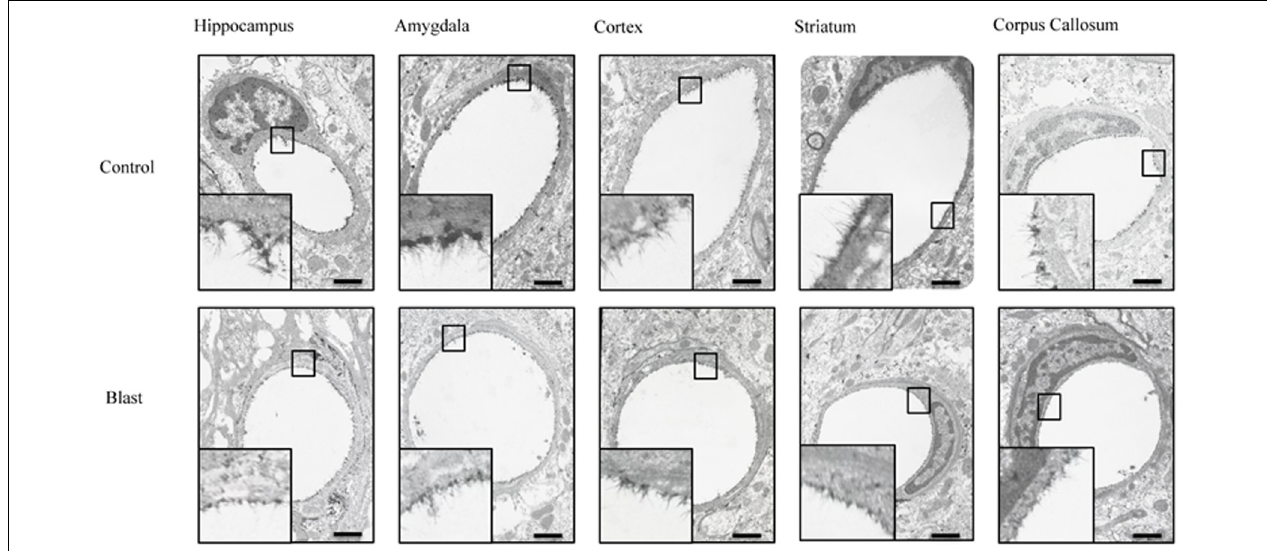
FIGURE 2 | Blast exposure reduced glycocalyx thickness in brain capillaries. Representative electron micrographs of capillaries from hippocampus, amygdala, cerebral cortex, corpus striatum, and corpus callosum taken from blast and sham blasted animals. Endothelial glycocalyx is the darkly stained filamentous layer present on the lumen of the capillary. All insets represent magnified image; scale bar = 500 nm.